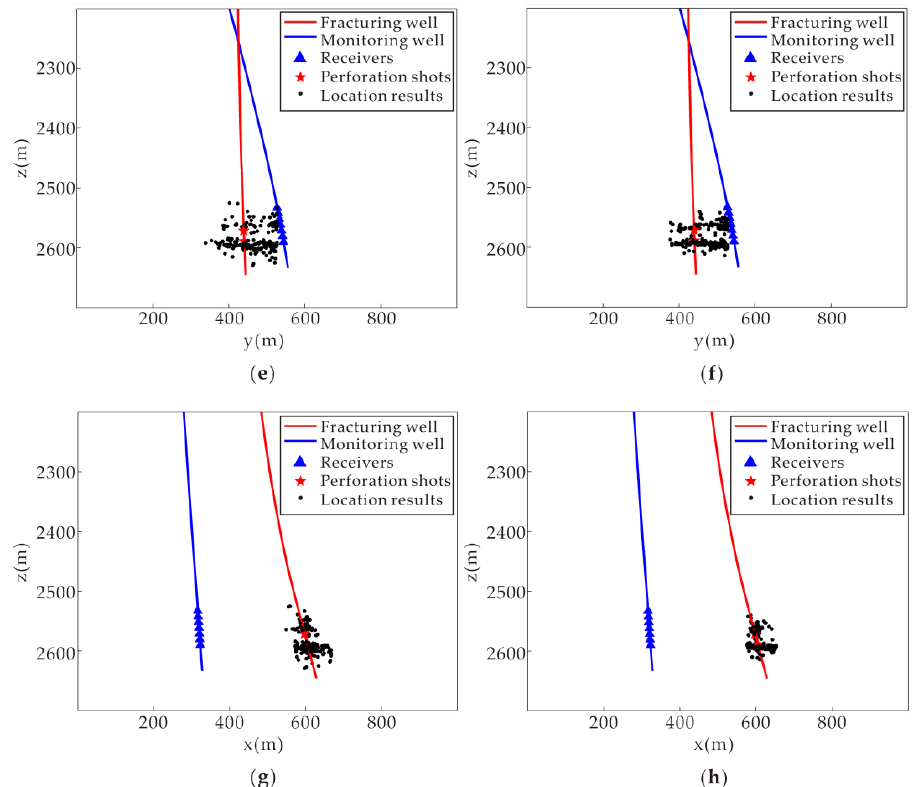
Figure 9. The location results through applying the conventional and improved polarity correc- tion methods. 3D display, map view in xy -plane and side views in yz - and xz -planes are shown in ( a , c , e , g ) for the conventional polarity correction method, respectively. The corresponding planes for the improved polarity correction method are described in ( b , d , f , h ). The black dots denote location